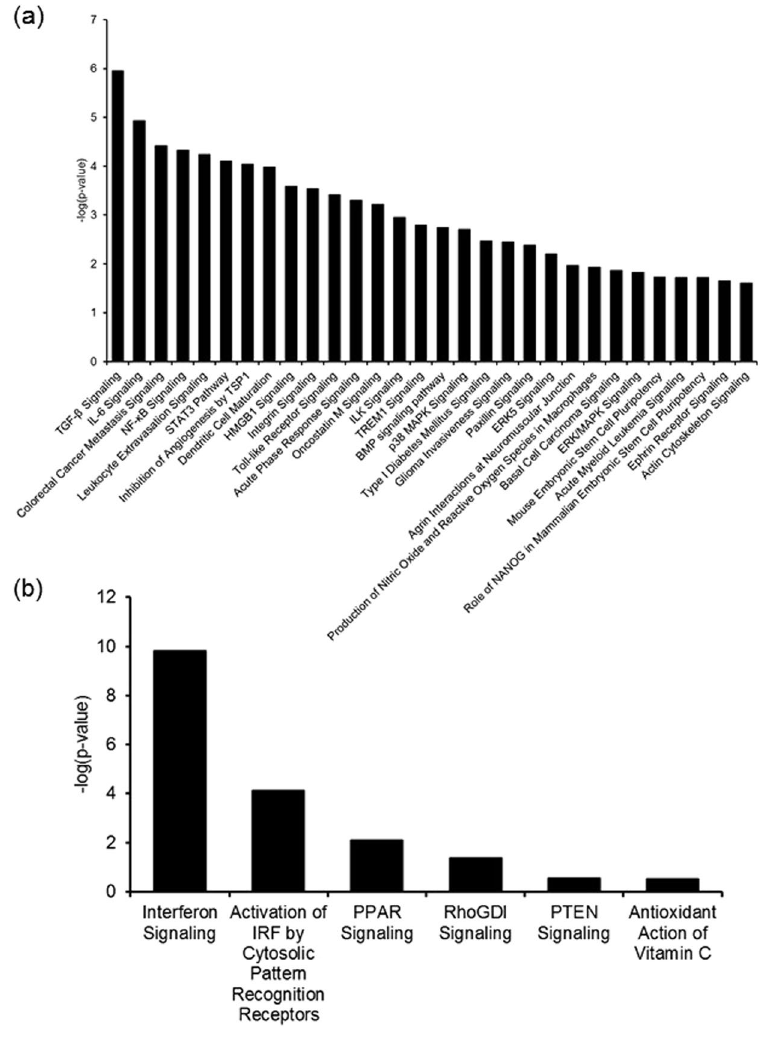
Figure 4. Canonical pathway analysis in bovine cumulus cells with FSH-priming. Ingenuity Pathway Analysis was used for predicting canonical pathways. The canonical pathways are identified and ranked by their z-score and -log( P -value). Down-regulated ( a ) and up-regulated canonical pathways ( b ) by FSH-priming were defined as a z-score ≤ − 1.5 and − log( P -value) > 1, and as a z-score ≥ 1.5 and − log( P -value) > 1, respectively. The significance of canonical pathway was defined as − log( P -value) >